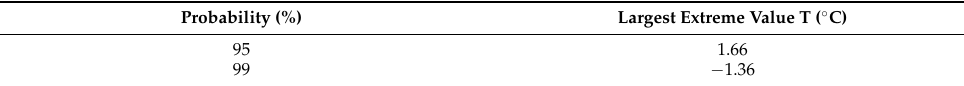
Table 2. Probability Madrid—Spain.